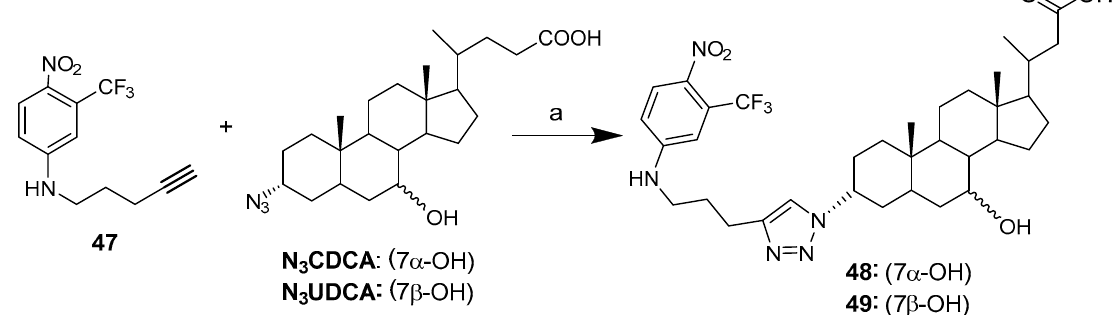
Scheme 6. Reaction conditions: (a) CuSO 4 · 5H 2 O, sodium ascorbate, THF: t -BuOH:H 2 O (1.5:1:1), microwaves: 80 ◦ C, 30 min;